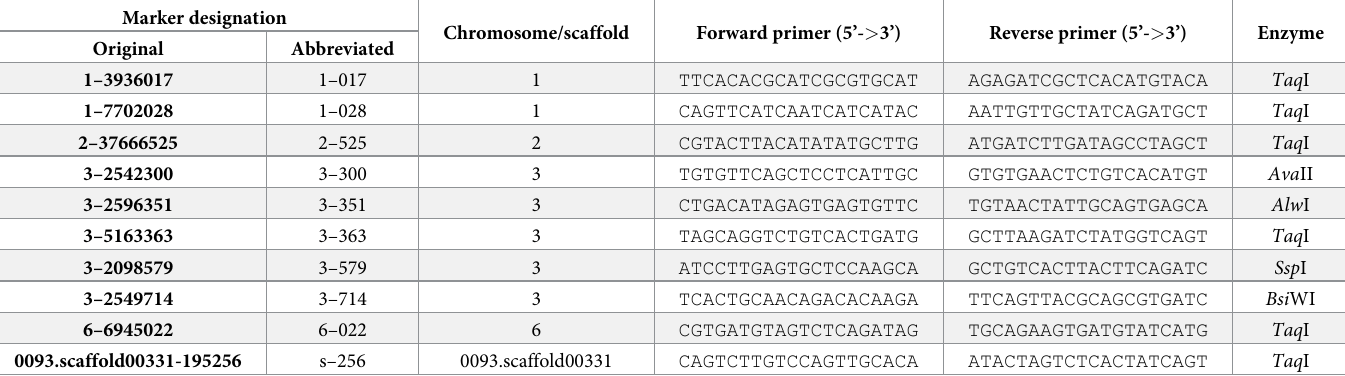
Table 1. CAPS markers selected for experimental